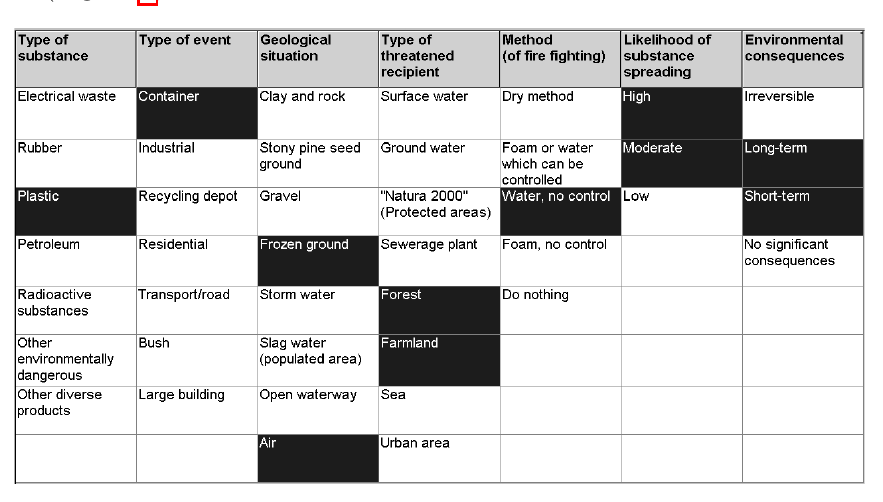
Figure 6: Morphological field for the environmental impact of different fire-fighting methods, with one hypothetical case